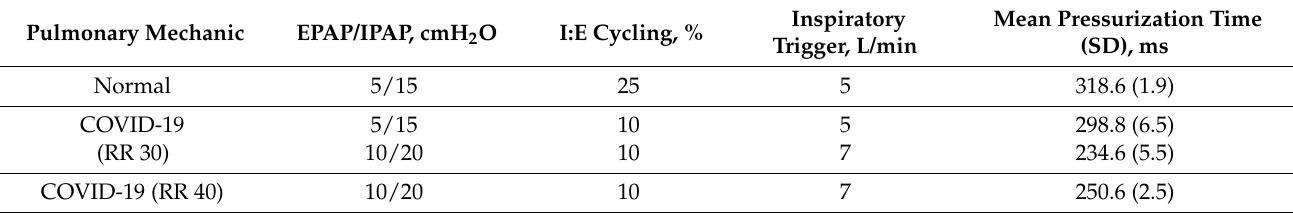
Table 3. Pressurization